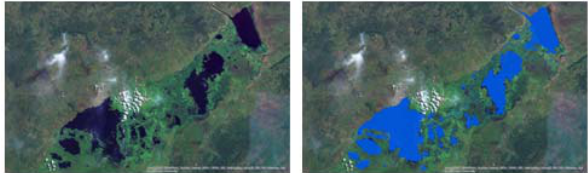
Figure 9. Detail of the global WB product, showing on left very high spatial resolution imagery from Google Earth and on right the 300m product